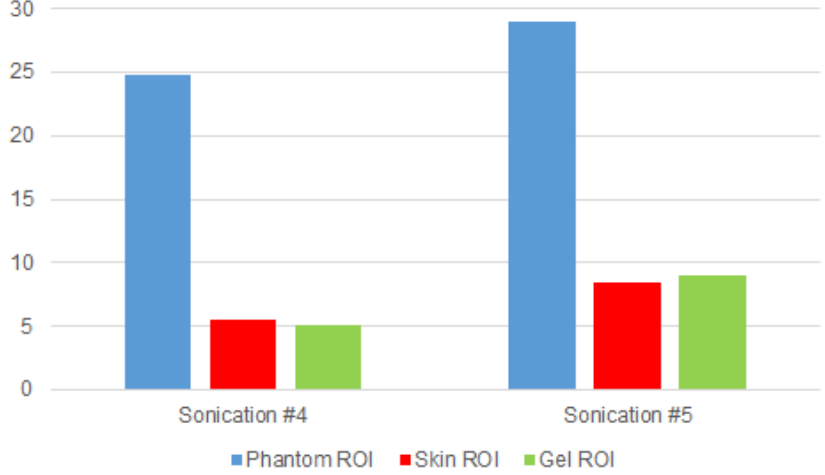
Figure 8. SNR values calculated for the phantom, skin, and gel ROIs. The phantom signal had the highest SNR values, while the gel area and the skin-interface area had the lowest SNR values.